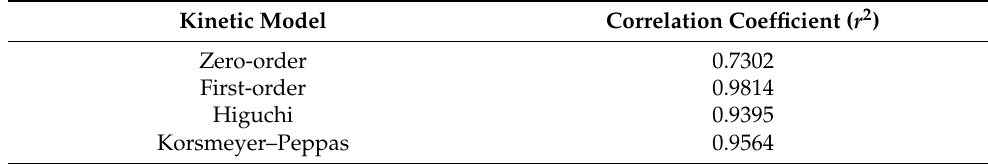
Figure 5. In vitro release of chloroquine, either free (closed circles) or entrapped within niosomes (open circles) over time in PBS at pH 6.9 and temperature of 37 °C. Table 1. Kinetic models of chloroquine release from niosomes.